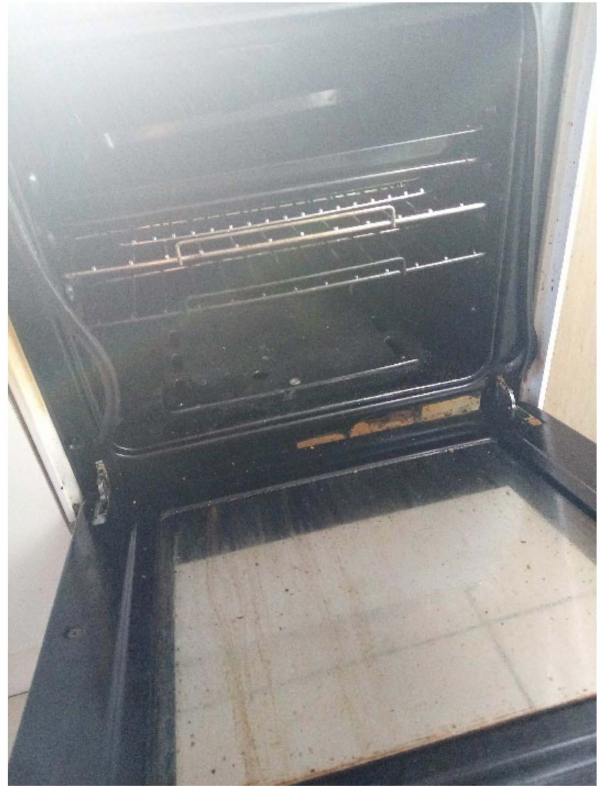
Figure 8. “Broken